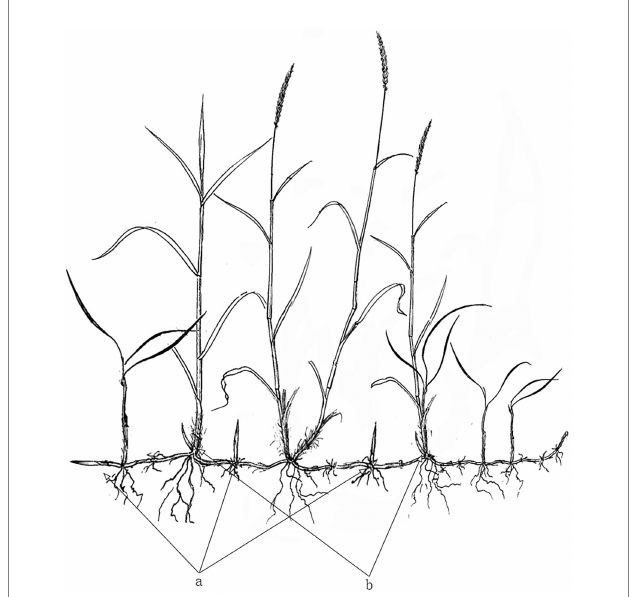
FIGURE 1 General morphology of various buds of Deyeuxia angustifolia . a, rhizome bud; b, tiller node